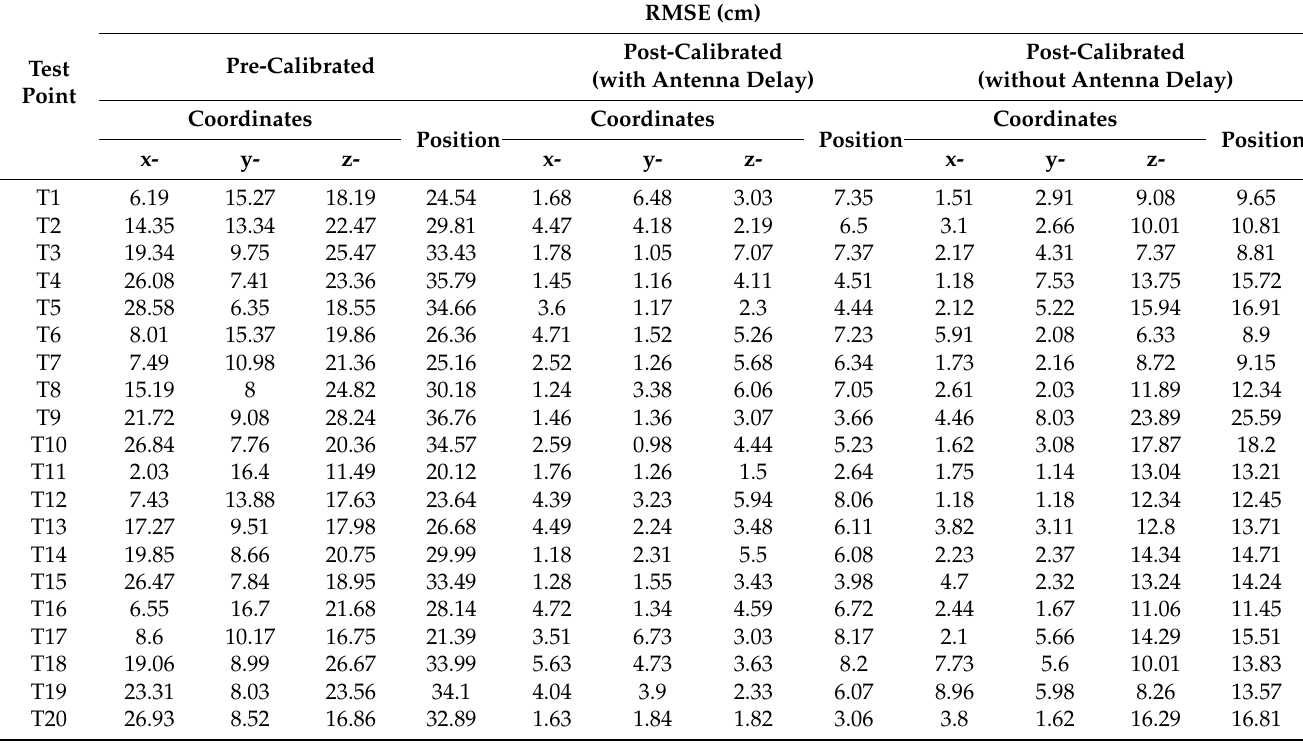
Table 1. Comparison of the RMSEs (unit: cm) of the estimated xyz-coordinates and positions of the mobile node at each test point from AltDS-TWR for the pre-calibrated, post-calibrated (with antenna delay), and post-calibrated (without antenna delay) cases of anchor